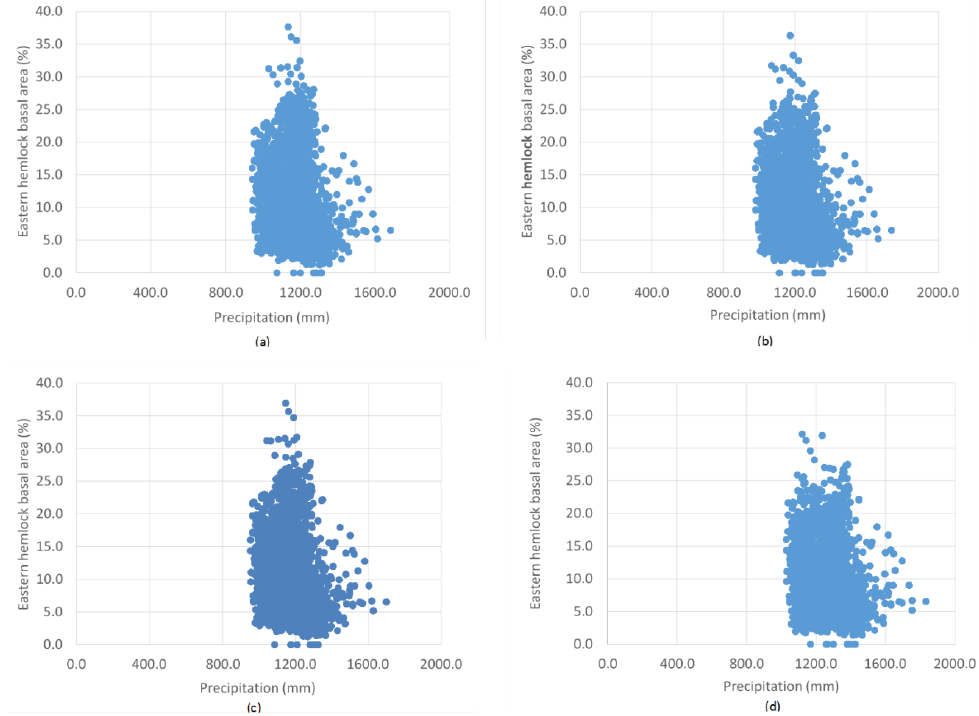
Figure 7. The range of precipitation and corresponding Tsuga canadensis basal area values of 2000 randomly generated points across Maine for ( a ) RCP 4.5 (2050), ( b ) RCP 4.5 (2100), ( c ) RCP 8.5 (2050), and ( d ) RCP 8.5 (2100).